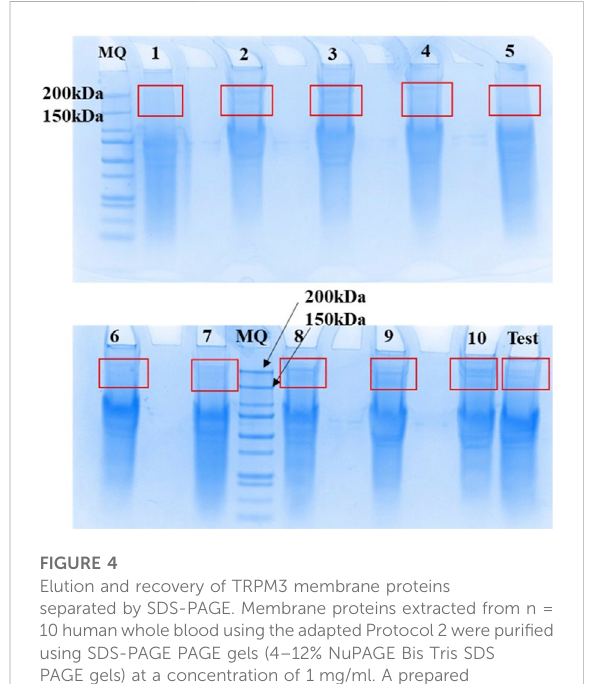
FIGURE 4 Elution and recovery of TRPM3 membrane proteins separated by SDS-PAGE. Membrane proteins extracted from n = 10humanwholeblood usingtheadaptedProtocol 2werepuri fi ed using SDS-PAGE PAGE gels (4 – 12% NuPAGE Bis Tris SDS PAGE gels) at a concentration of 1 mg/ml. A prepared TRPM3internalstandard(MQ)wasused,andaftermigrationbands of gel between 150 kDa and 200 kaDa (expected TRPM3 MW) were excised with a scalpel as illustratedin Figure, for in-gel digest of protein samples. Figure obtained from Promise